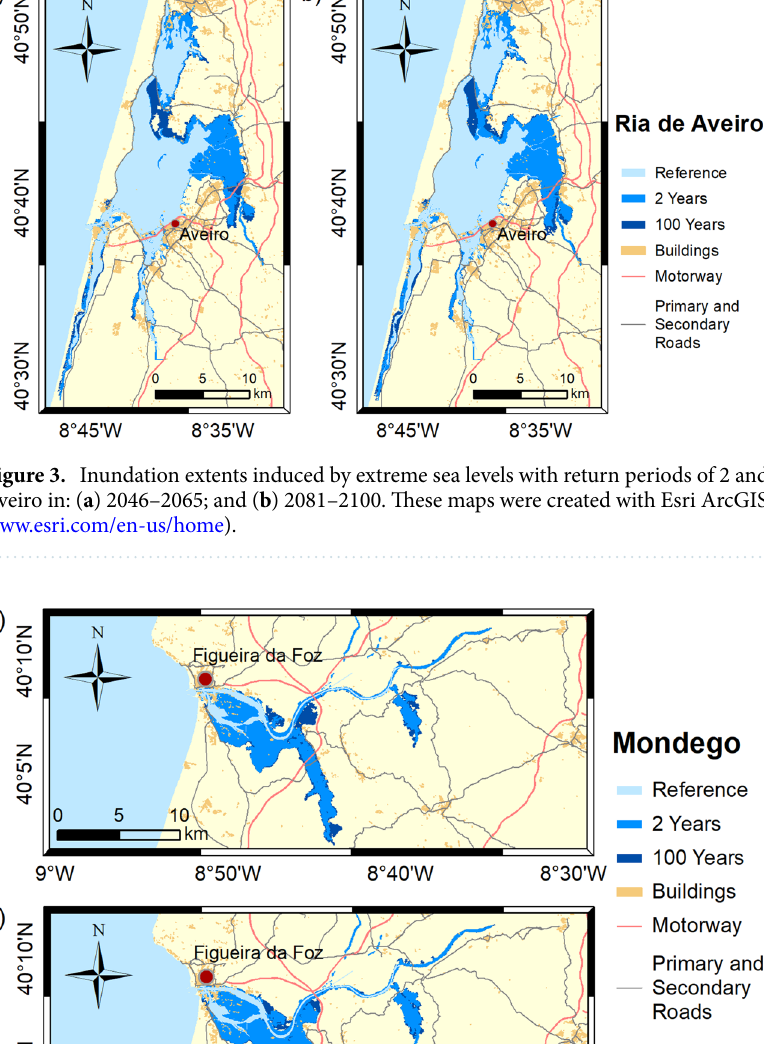
Figure 8 represents the evolution of the water level range (combining tides and storm surges) along transects defined in each estuary (see Supplementary Figs. S1–S5) for each extreme sea level scenario. The water level range ( �η T ), defined as the difference between the maximum water level and the next low water level (see “Methods” section), provides information about the amplification or attenuation of the long-wave as it propagates within each estuarine system. In Ria de Aveiro (Fig. 8a), the �η T is largest (2.4 m for all scenarios) at the mouth and suddenly decreases in the inner lagoon (first 2 km). After that point, and moving northward (S. Jacinto channel), the �η T reduces more slowly until the 9–10 km, and then stabilizes until the end of the transect. The pattern of �η T reduction is also evident when moving southward (Mira channel) and is more pronounced after the 7–8 km. The results also show that the reduction in �η T increases as the inundation area becomes larger. In the Mondego estuary (Fig. 8b), �η T is also reduced as the flood propagates upstream, and this reduction is more pronounced after the 14 km. It is also verified that the reduction in �η T is more pronounced when extreme sea levels are high. In the Tagus estuary (Fig. 8c), �η T evolves differently along the transect: it amplifies from the inlet up to